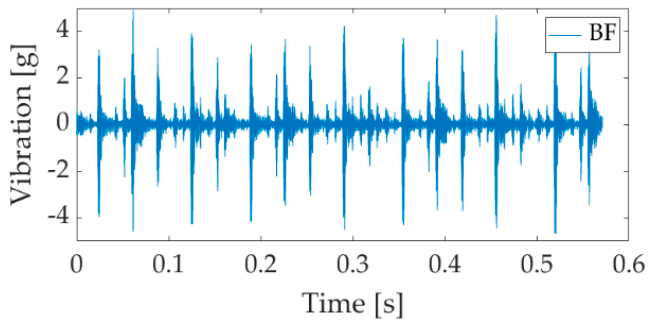
Figure 8. Experimental results of the vibration signal under bearing fault (BF). Energies 2020 , 13 , x FOR PEER REVIEW